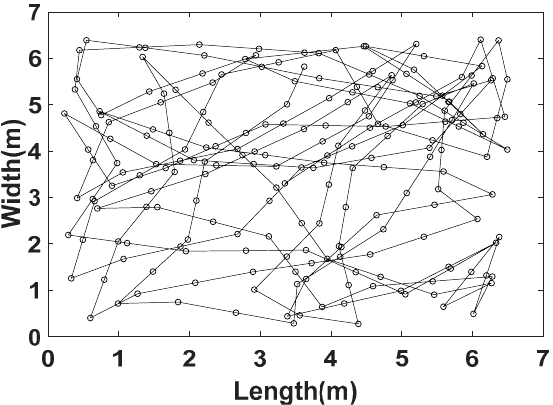
Figure 4. Illustration of a node traveling pattern using RW mobility model.